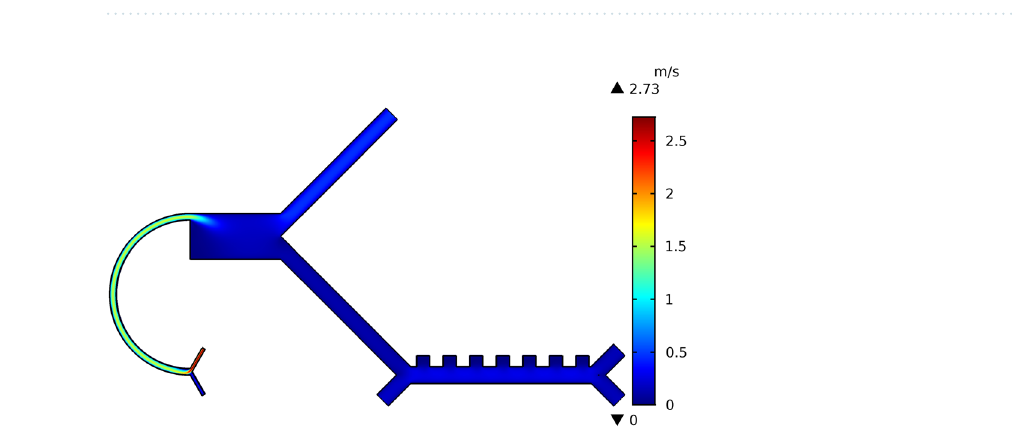
Figure 9. Separation efficiency versus aspect ratio of RBC and Platelets. Low AR of the proposed combined geometry was found suitable for maximum separation efficiency.